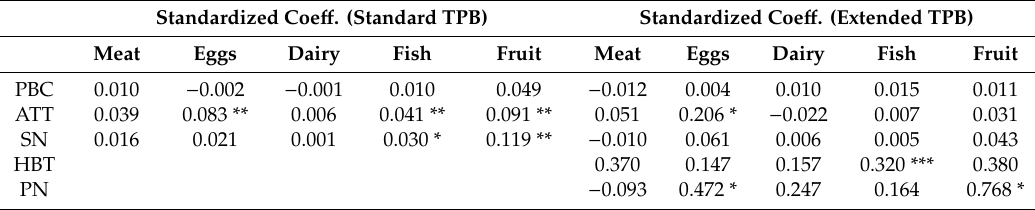
Table 6. Indirect e ff ects of TPB constructs on frequency of consuming meat, eggs, dairy, fish, and fruits of standard and extended TPB